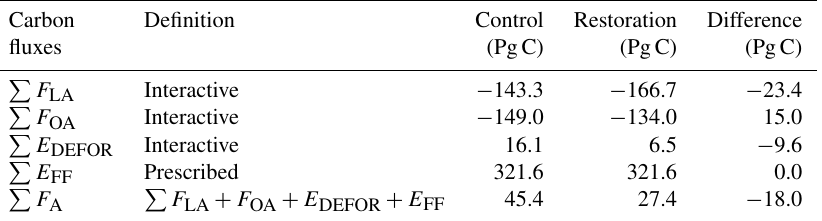
Carbon Definition Control Restoration